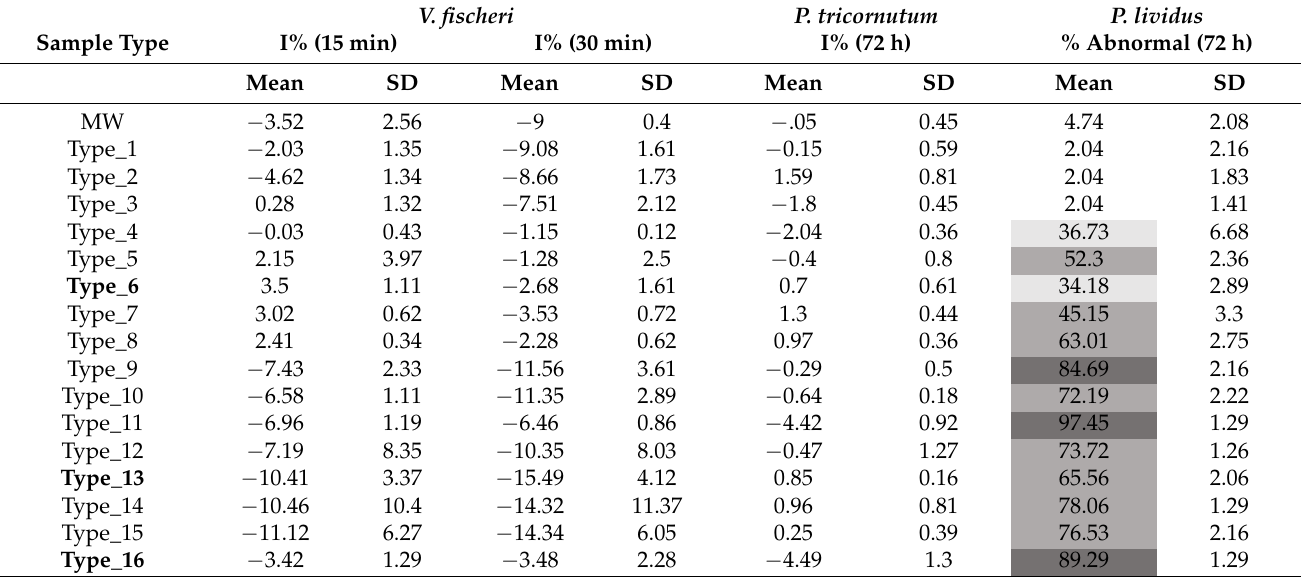
Table 3. Synthesis of the ecotoxicological responses for each tested packaging leachate type. Data are expressed as mean effects (% ± standard deviation, SD) at the maximum dose tested (100% for P. tricornutum and P. lividus ; 90% for V. fischeri ). MW = marine water, i.e., negative control. White bars indicate no effect (<20%); light grey, grey and dark grey bars show slight (20–39%), moderate (40–79%) and severe (80–100%) effects. Values in bold represent the sample type selected for the subsequent analysis.